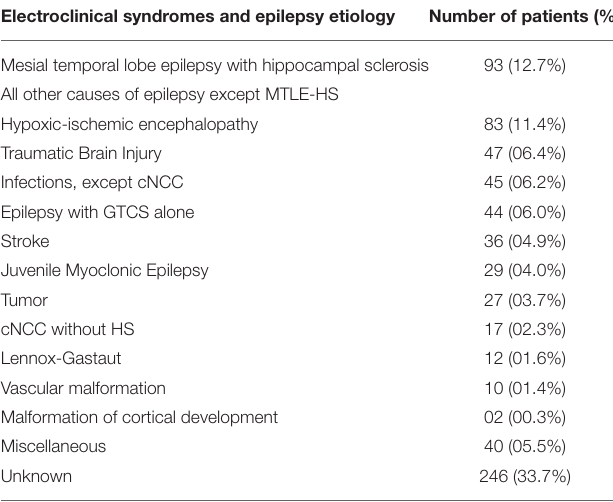
TABLE 2 | Patients according with electroclinical syndromes and epilepsy etiology. Electroclinical syndromes and epilepsy